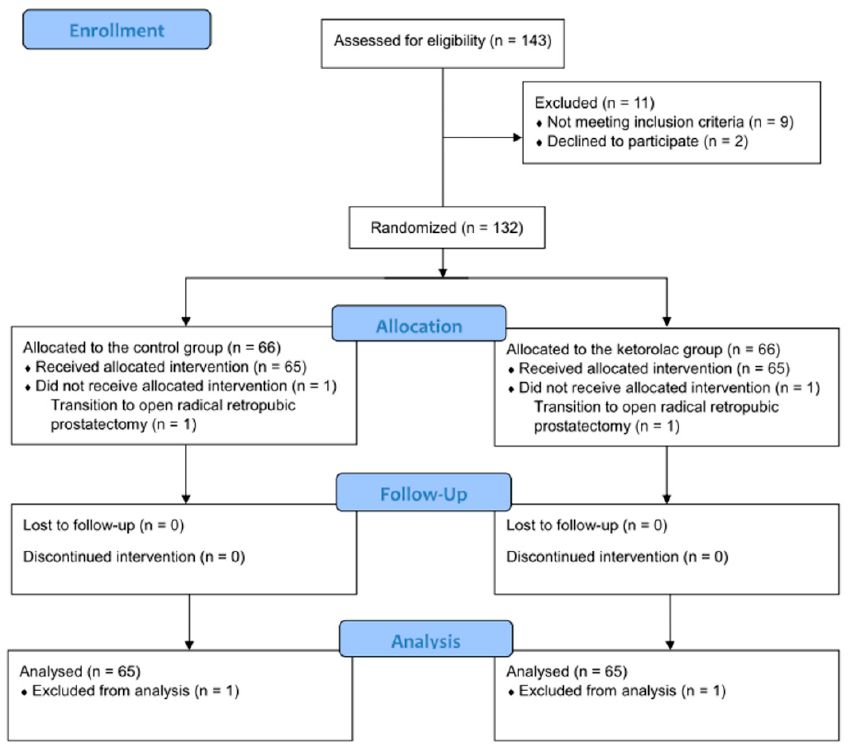
Figure 1. A CONSORT flow chart. Table 1. Characteristics of study participants.